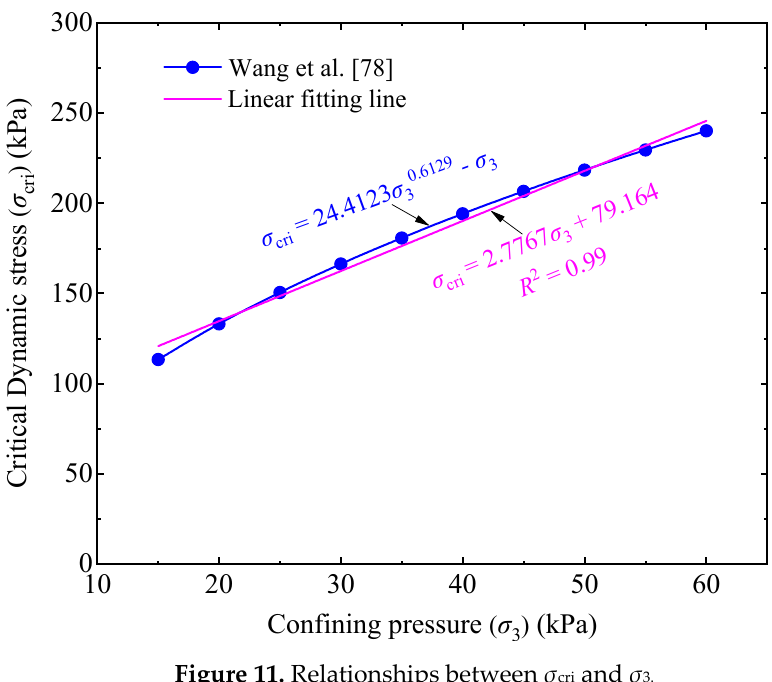
Figure 11. Relationships between σ cri and σ 3.